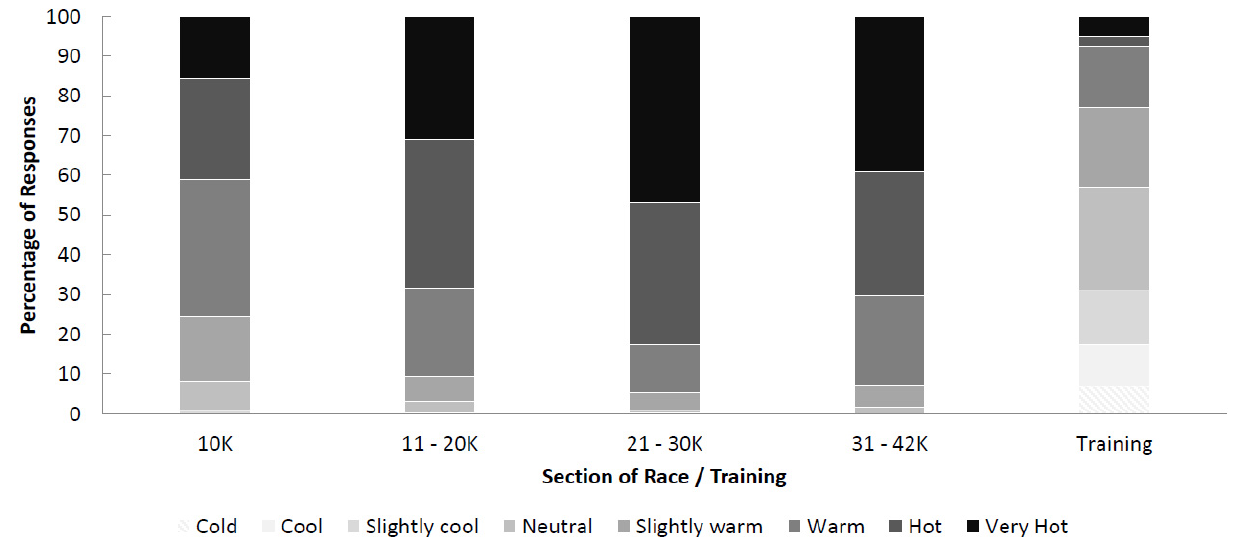
Figure 4. Thermal sensation during the VMLM 2018 and a typical training session during winter/spring in the UK in preparation for the 2018 VMLM.